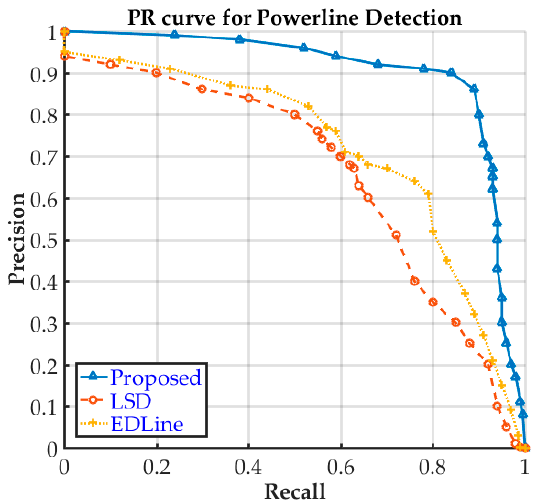
Figure 13. PR-curve for power line detection shows dominant performance of proposed power line detection scheme.